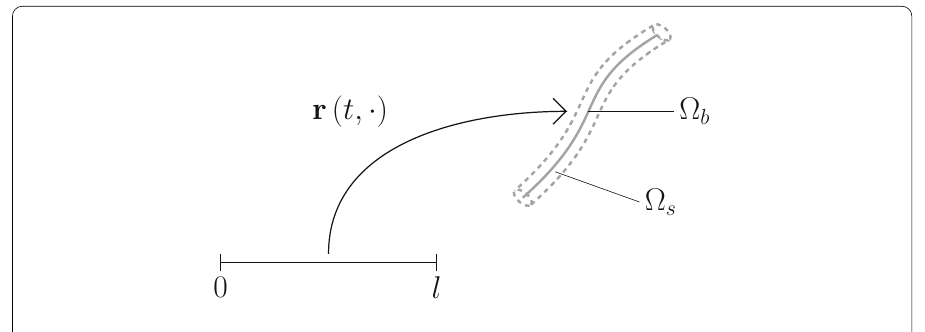
Fig. 1 Depiction of a beam and its centerline representation by a